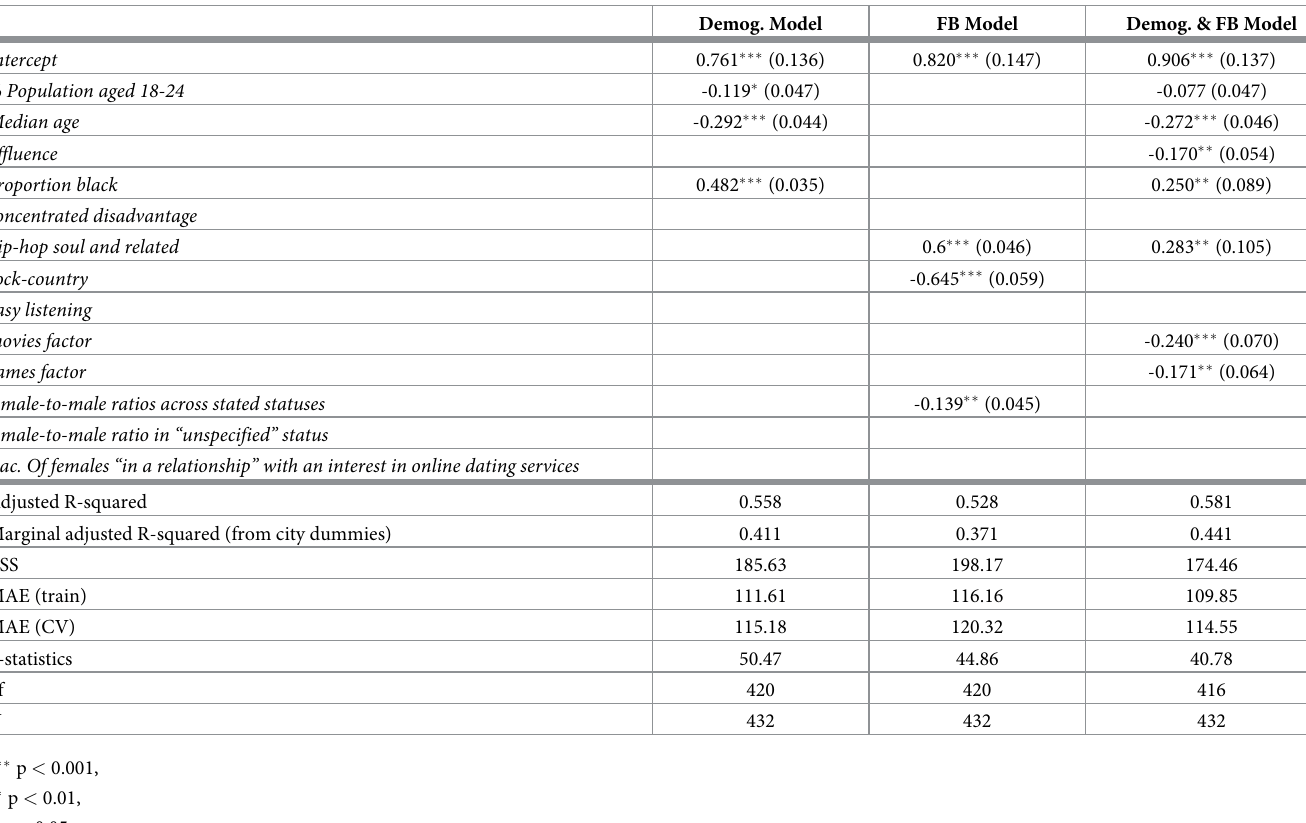
Table 5. Parameter estimates and fit statistics for regression models predicting robbery